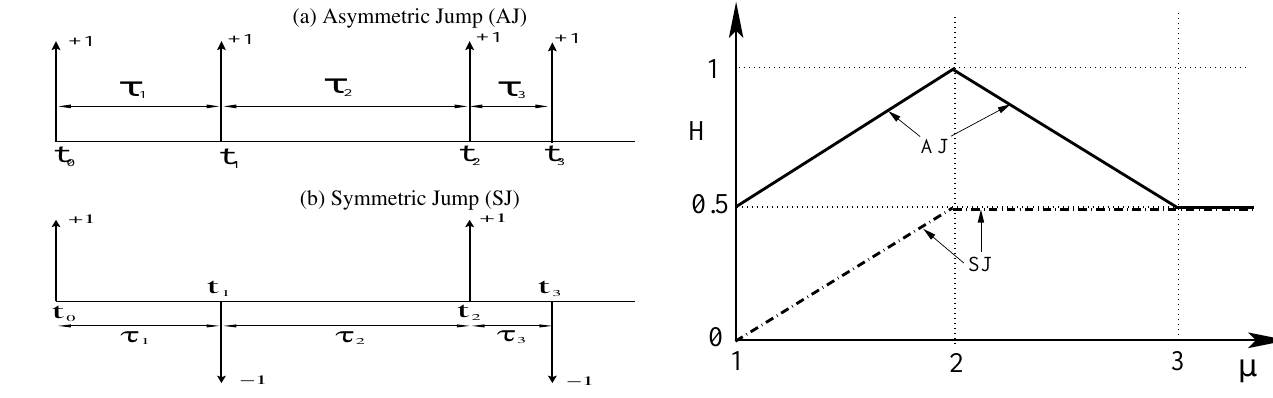
Fig. 5. The AJ and SJ walking rules for the “velocity signal” ξ ( t ) .